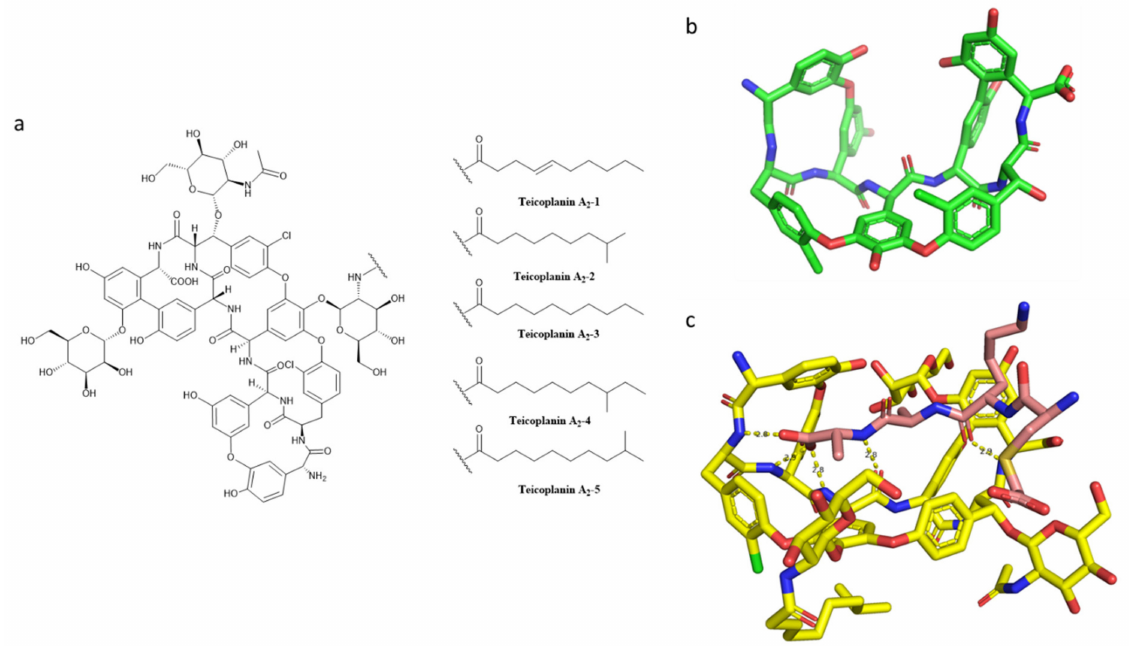
Figure 8. ( a ) 2D structure of teicoplanin, in its different forms. ( b ) 3D structure of teicoplanin aglycone (TAG: PDB ID 6TOV), DMS (dimethyl sulfoxide was removed from the original pdb file of the crystal structure) [171], and ( c ) teicoplanin in complex with D -Ala- D -Ala residue with polar contacts (PDB ID: